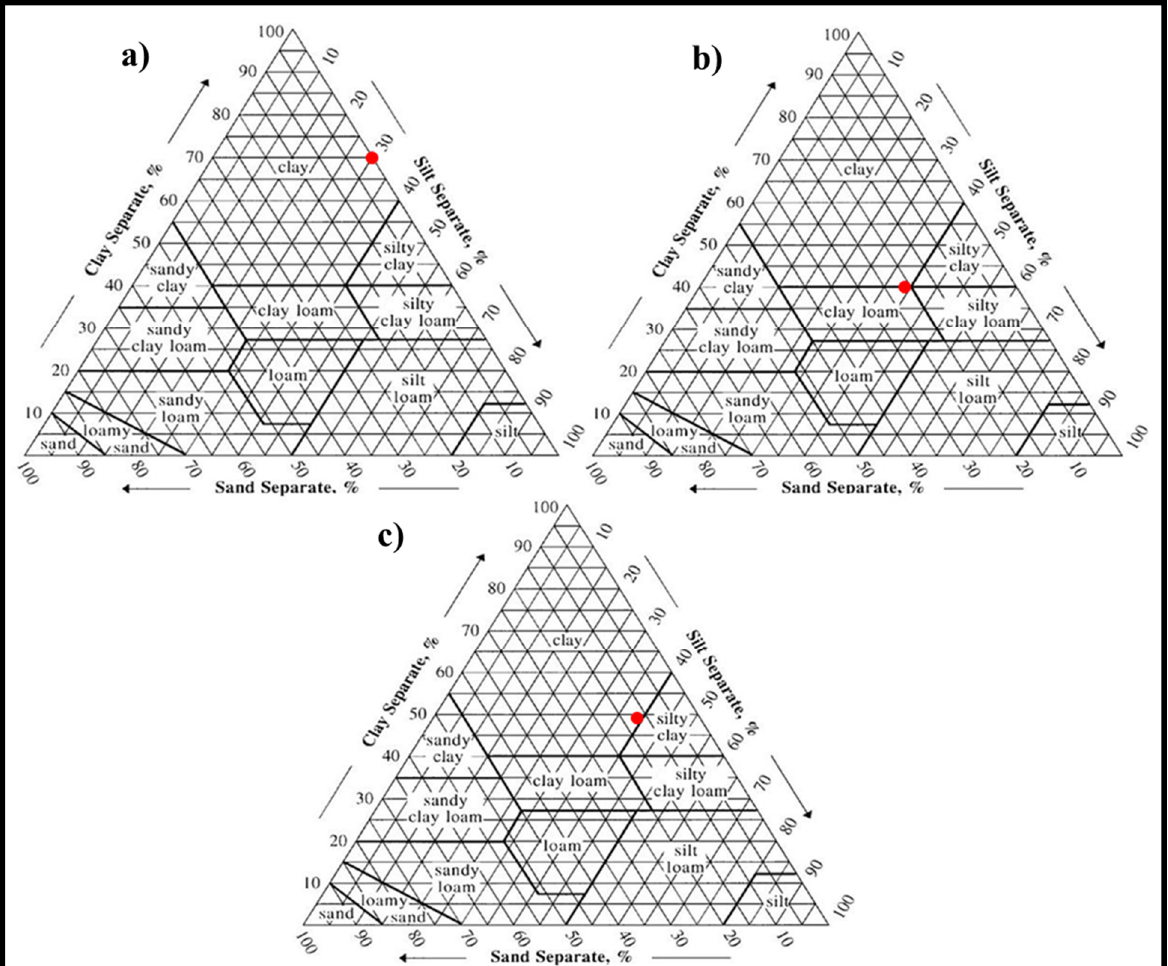
Figure 2. Soil texture analysis of ( a ) DM, ( b ) HM, and ( c ) SM clays.